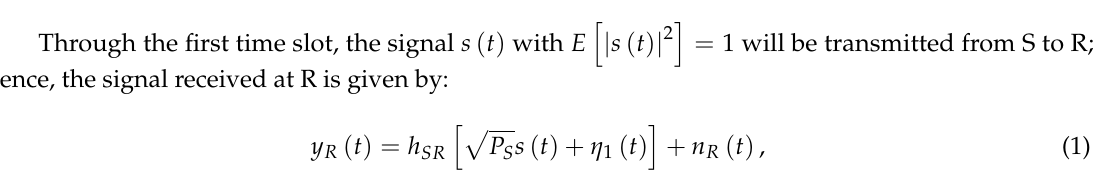
Figure 1. Illustration of the system